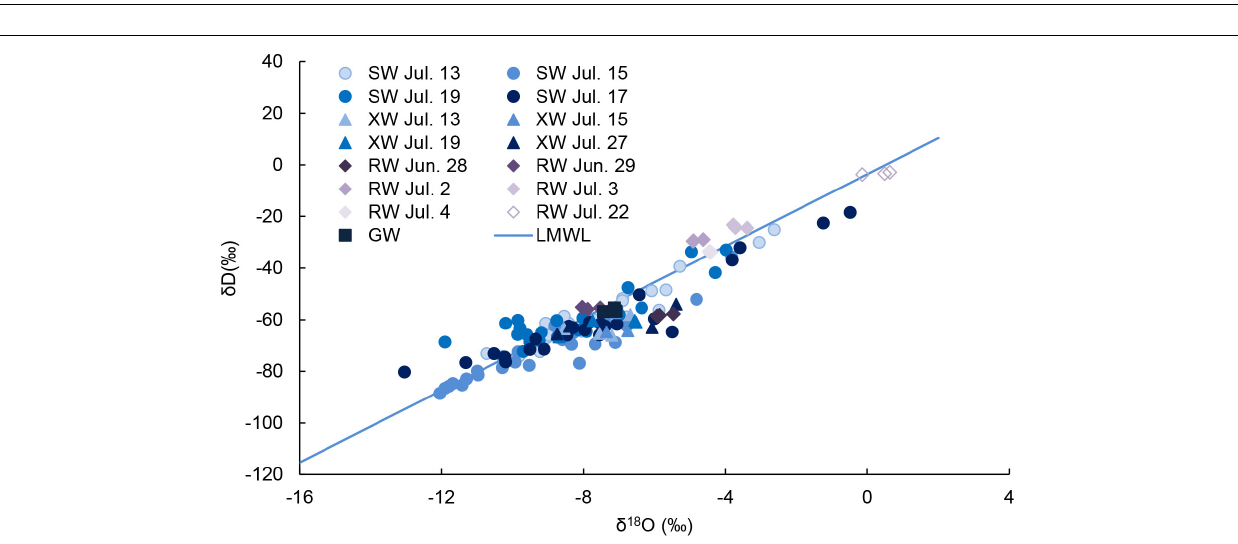
FIGURE 1 | Soil water content in the Caragana intermedia community 1 day before and 1, 5, and 13 days after the rain on July 14, 2016. Different uppercase letters mean significant difference between days; different lowercase letters mean significant difference between depths.